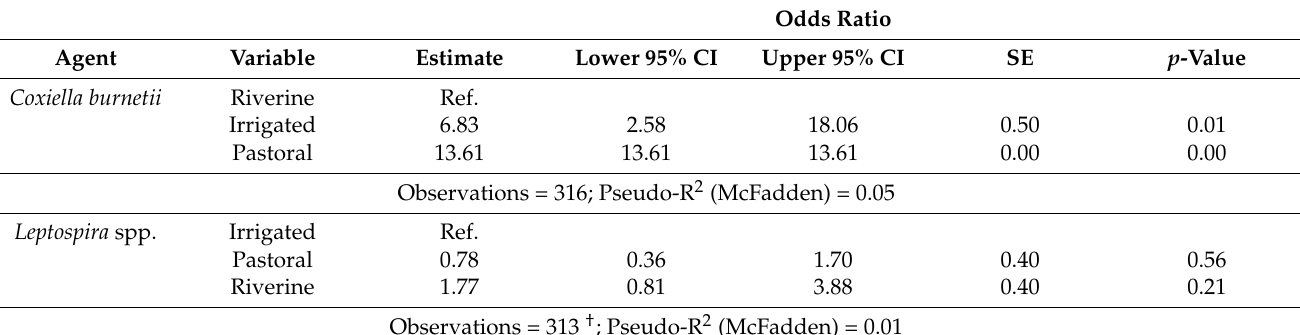
Table 4. Results of the survey-weighted univariable logistic regression models of seroprevalence for the different sampling sites. Due to the few positives, data on Brucella spp. was not analyzed. Models were built using a causal diagram-based approach to determine total effects. Therefore, all intervening variables were excluded from the analyses.